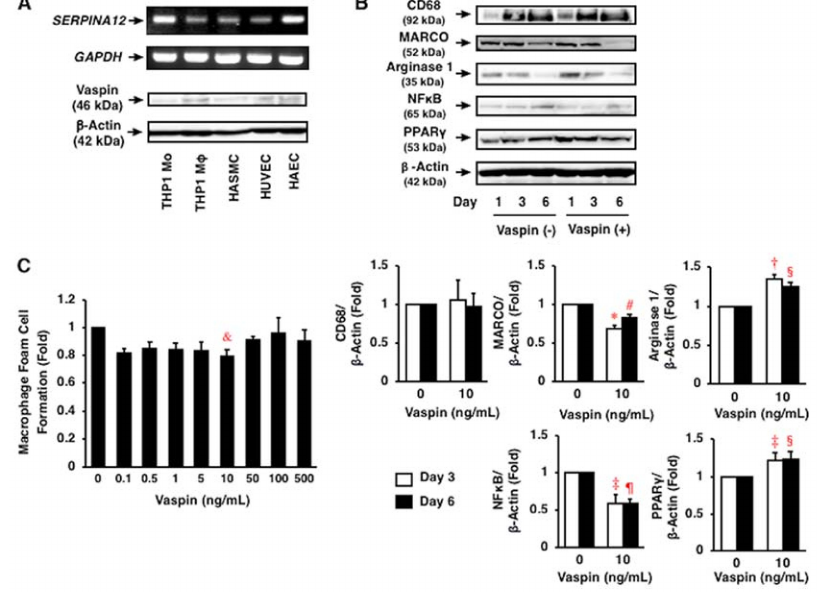
Figure 2. Expression of vaspin and its effects on inflammatory phenotype and foam cell formation in human macrophages. ( A ) Expression of SERPINA12 and vaspin in human vascular cells, such as THP1 monocytes, their derived macrophages, HASMCs, HUVECs, and HAECs was assessed by RT-PCR and immunoblotting. GAPDH and β -actin served as loading controls. ( B ) Effects of vaspin on inflammatory phenotypes in THP1 monocyte-derived macrophages were assessed by immunoblotting ( n = 3–4). * p < 0.0005, † p < 0.005, ‡ p < 0.05 vs. control on day 3; # p < 0.005, § p < 0.05, ¶ p < 0.0005 vs. control on day 6. ( C ) Effects of vaspin on oxidized LDL-induced foam cell formation in THP1 monocyte-derived macrophages were assessed by cholesterol esterification assay ( n = 5). 1 fold = 5.72 ± 0.65 nmol/mg cell protein. & p < 0.05 vs. 0 ng/mL of